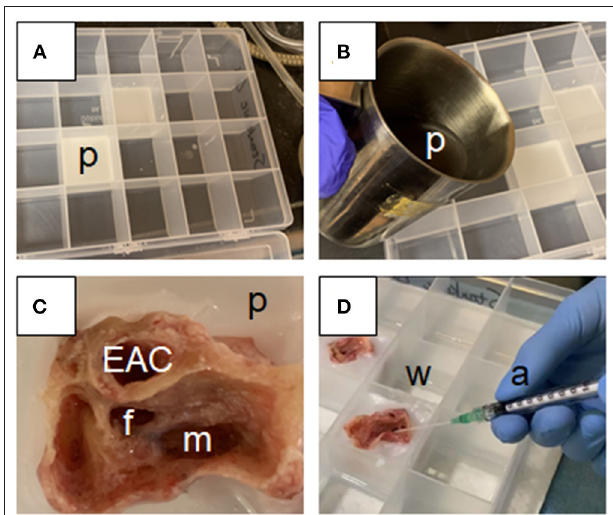
FIGURE 2 | Experimental set-up for measurement of trans-tympanic drug delivery in situ : (A) Paraffin is heated to 60 ◦ C, poured into a clear plastic compartment organizer, and allowed to solidify to form a 1cm deep paraffin base (p); (B) Once the base is solidified, additional hot paraffin (p) is added to an additional 1cm depth; (C) The post-mastoidectomy temporal bone is set into the hot paraffin such that the external auditory canal (EAC) is oriented vertically, and becomes fixed in place as the cooling paraffin (p) forms a watertight shell surrounding the drilled mastoid (m), with access to the lateral surface of the tympanic membrane obtained via the EAC and to the medial surface via the facial recess (f); (D) Extra compartments within the compartment organizer are filled with water at 37 ◦ C to maintain humidity and consistent temperature throughout the experiment (w). A series of angiocatheters (a) are used to perform the following tasks throughout the experiment: filling of the middle ear space with normal saline via the antrum, applying drug formulation to the tympanic membrane via the EAC, and collecting middle ear aspirate via the facial